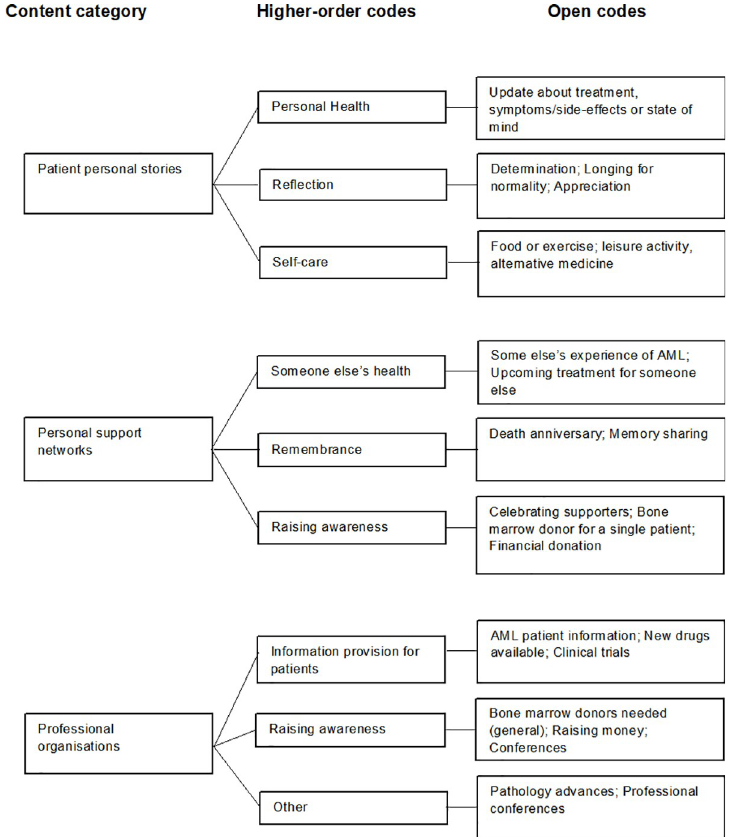
Fig 2. Process of generating categories.